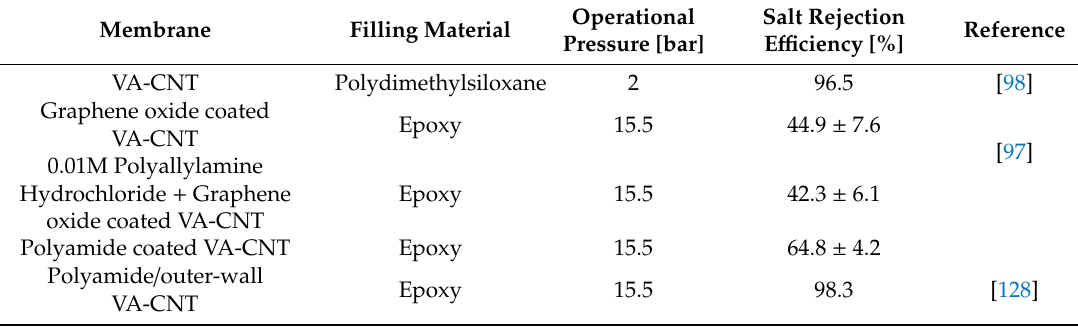
Table 4. Comparison of salt rejection e ffi ciency according to various vertically aligned carbon nanotube (VACNT) membranes and operational